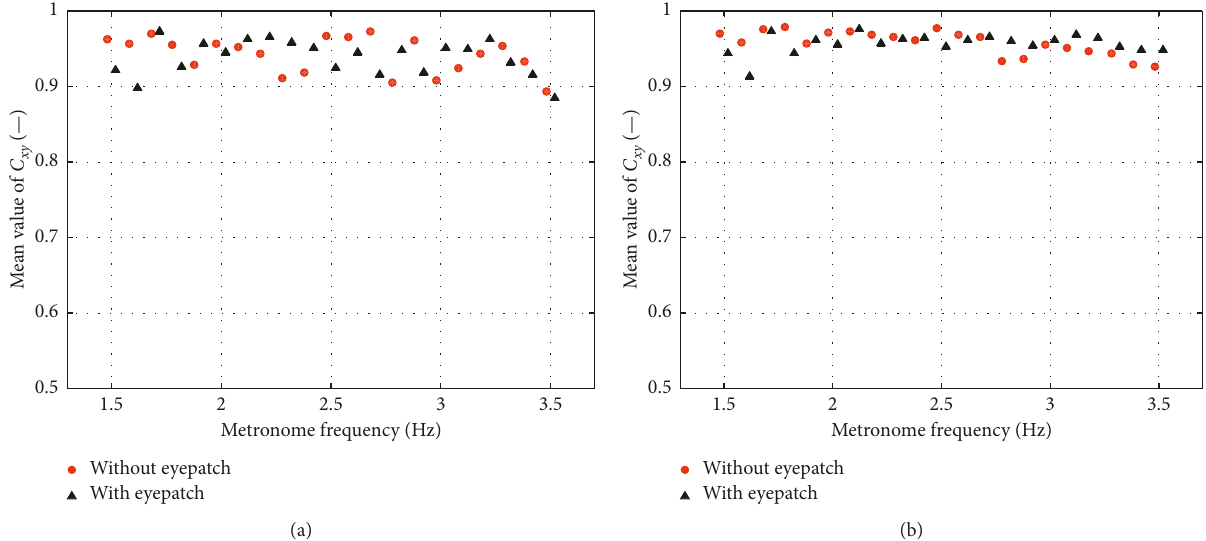
Figure 37: Comparison of the mean values of the (a) lateral coherence coefficients and (b) frontal coherence coefficients for visual stimuli, with and without an eyepatch.